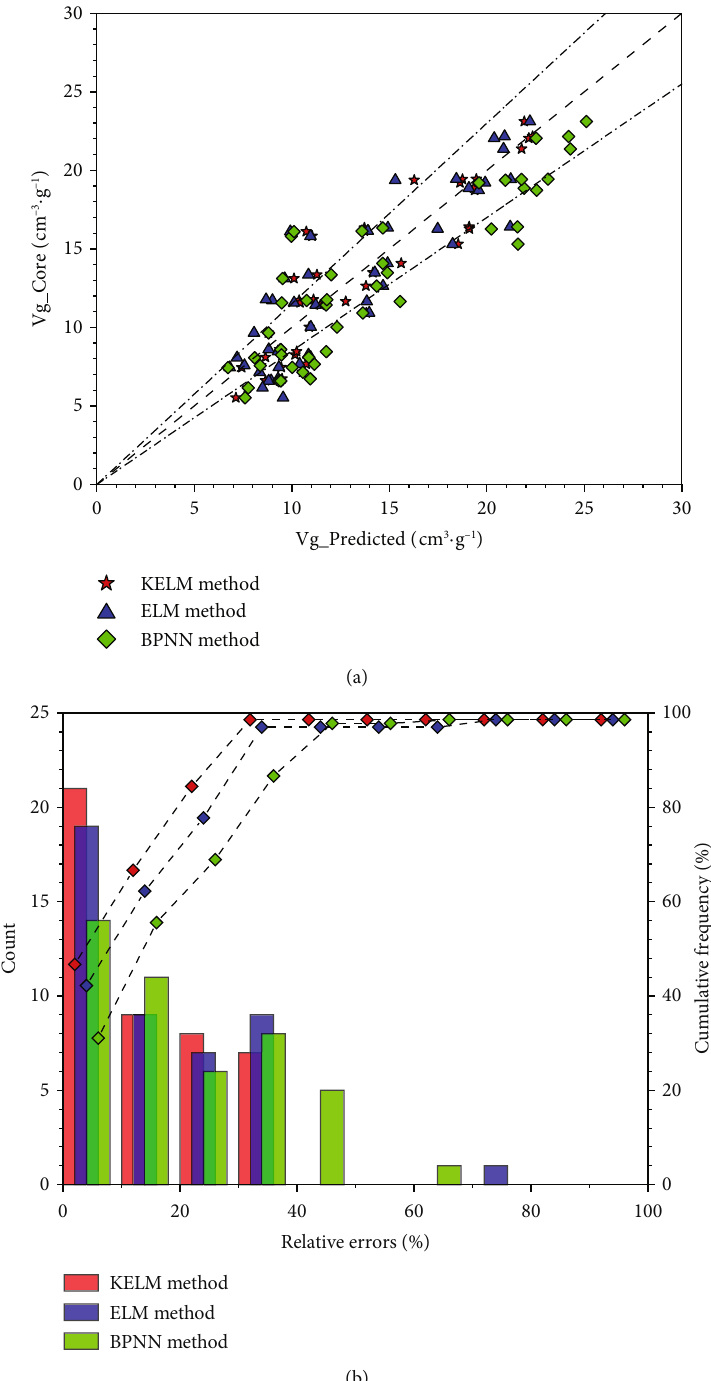
Figure 19: Performance of the three methods in the same dataset: (a) rendezvous plot of predicted results and laboratory results; (b) cumulative frequency diagram of relative errors of the three